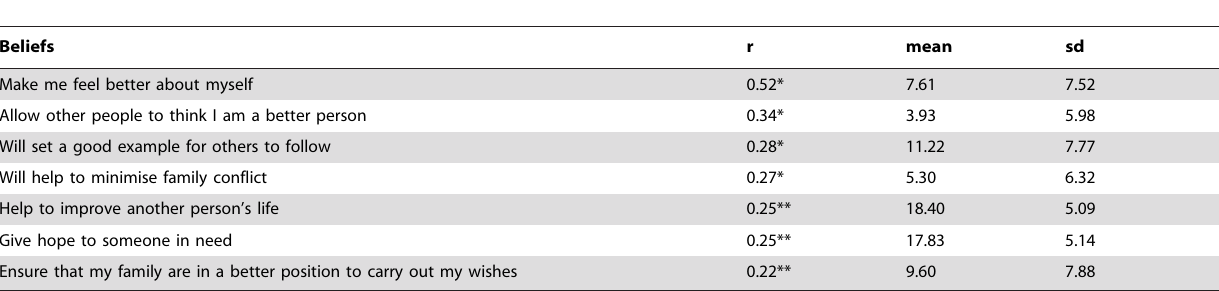
Table 3. Means and standard deviations of behavioural beliefs and Pearson’s correlations (r) of behavioural beliefs with intention.